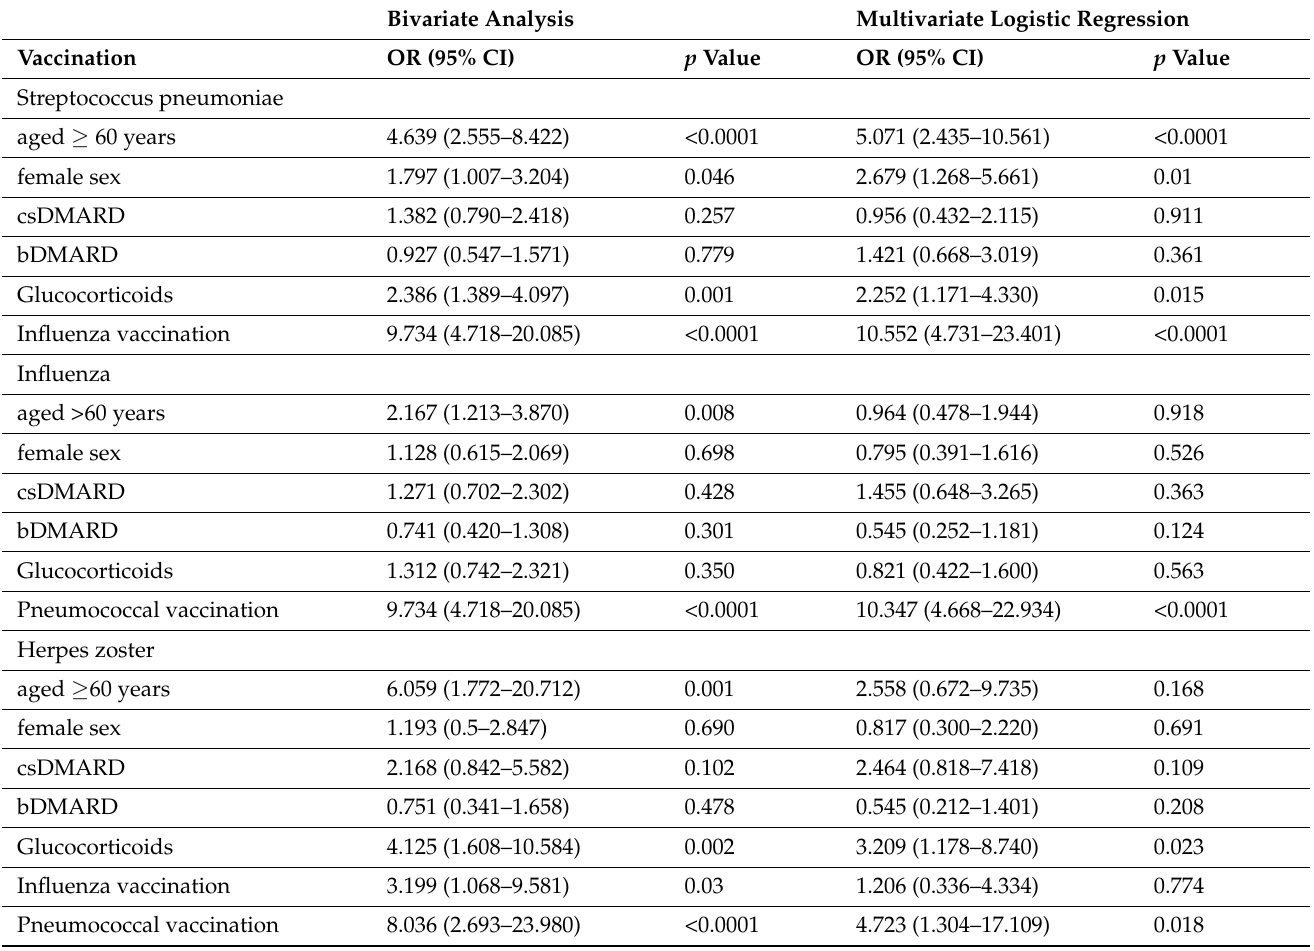
Table 3. Bivariate and multivariate logistic regression analysis of the association between vaccination status and the patients’